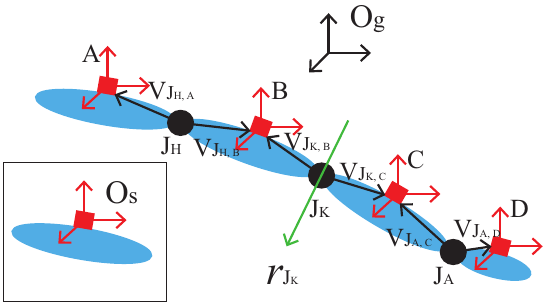
Figure 1. A model of a human left lower limb connected by joints. The human lower limb joints can be classified into a spherical joint and hinge joint, where the hip and ankle are spherical joints and the knee joint is the hinge joint. At time step t ( t = 1 . . . n ), the accelerations measured by the accelerometers are denoted as a S ( t ) . The angular velocities measured by the gyroscope are denoted as w S ( t ) , S ∈ { A, B, C, D } . (1) The spherical joint The spherical joint is analyzed on the hip joint as an example and is applicable for the ankle joint. Assuming A and B are connected through the joint J H , the position of